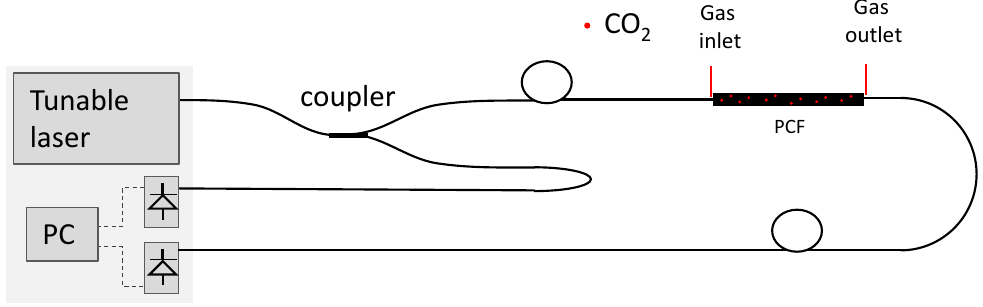
Figure 3. Complete sensor schematic setup, including the HC-PCF based gas/light interaction cavity and portable computer (PC) based acquisition and processing unit.